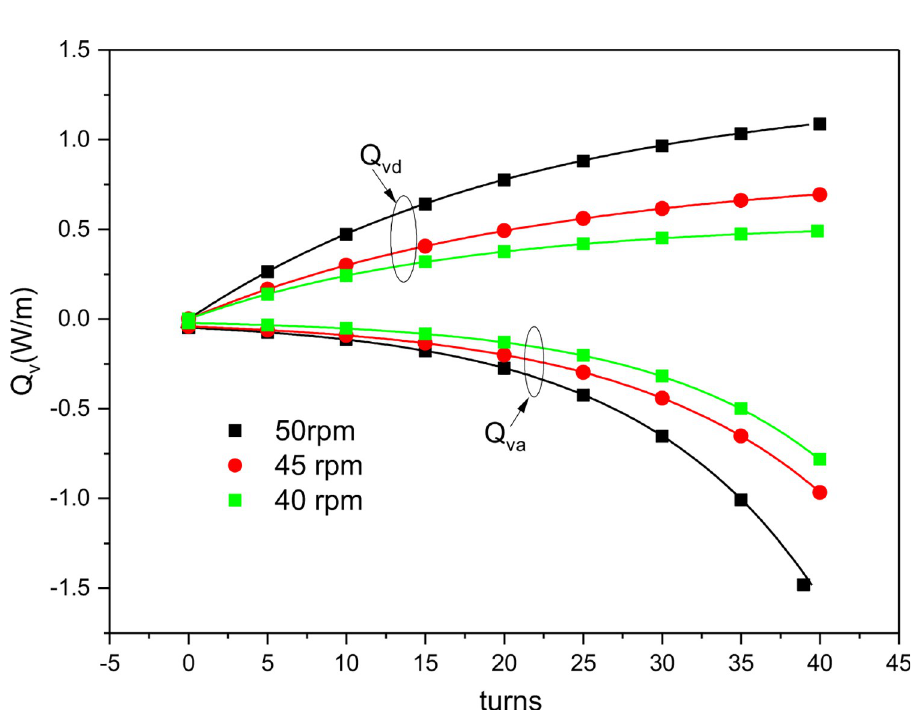
Fig 11. Simulated PHCCs as a function of the stepping motor speed ( n 1 ).